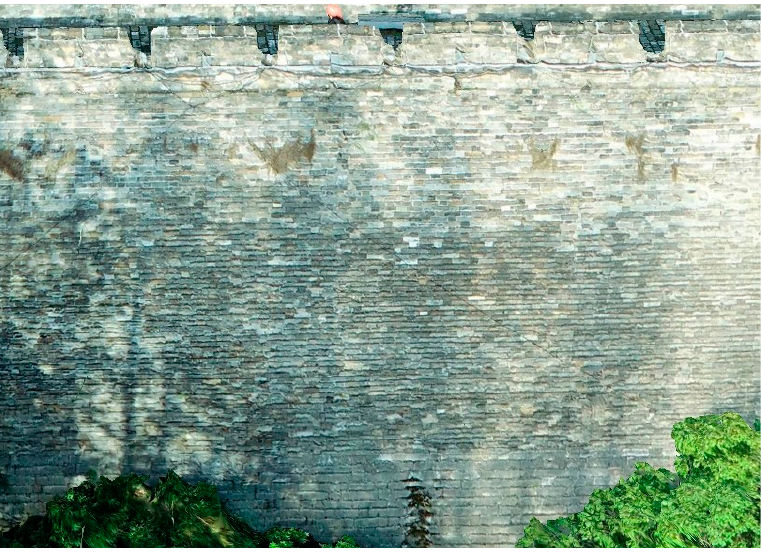
Figure 15. The texture of Nanjing City Wall’s inner wall.